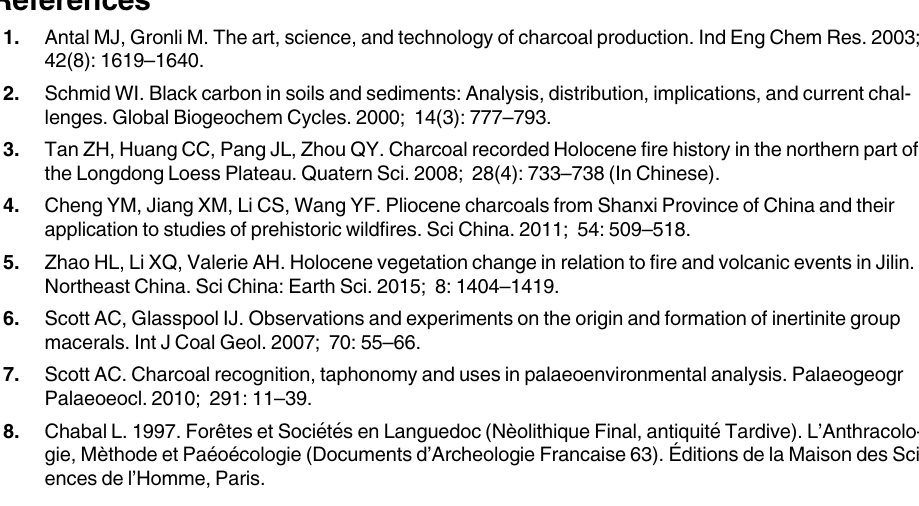
S1 Table. List of the species analysed with their weights, volumes and density changes, and